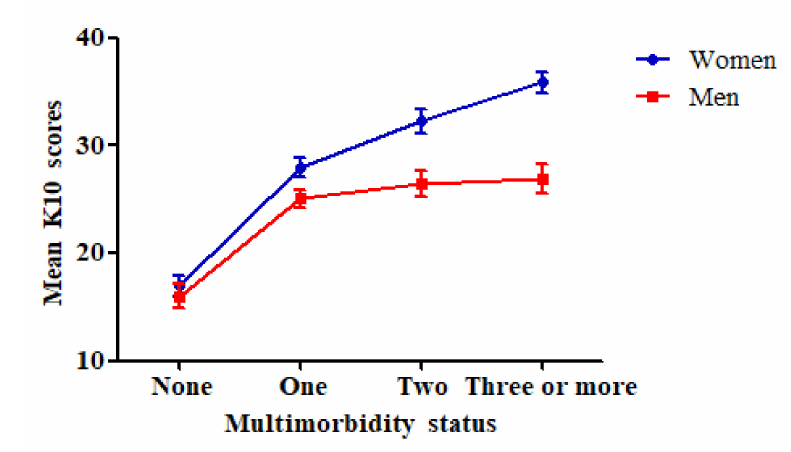
Figure 1. Mean K10 score for each multimorbidity status by